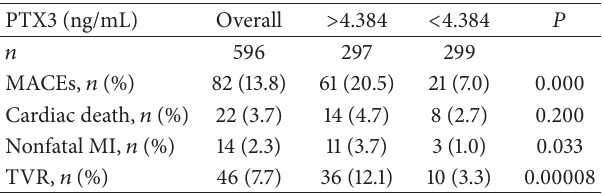
Table 3: Risk stratification of patients after coronary stent implan- tation based on increased PTX3 (above the median value of 4.384 ng/mL).